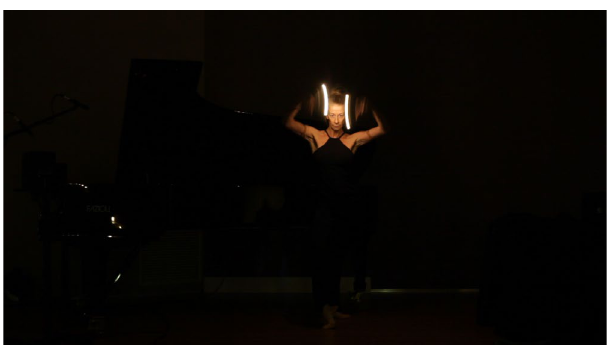
Figure 10 . The performer in action (Case 5).